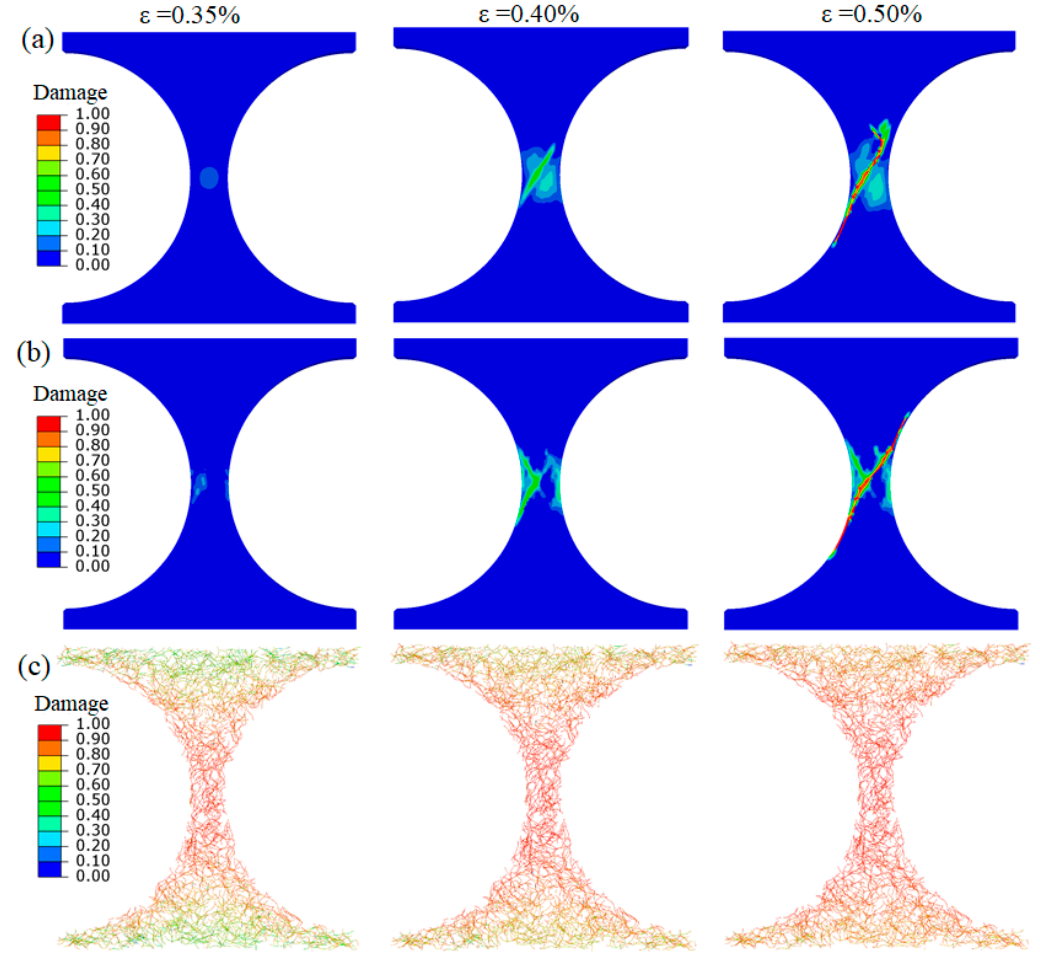
Figure 6. Damage development in the matrix of ( a ) the pristine FRC and ( b ) FRC with 0.5 wt% of homogeneously distributed CNTs; debonding ( c ) at CNT/matrix interface in the composite with 0.5 wt% CNTs.